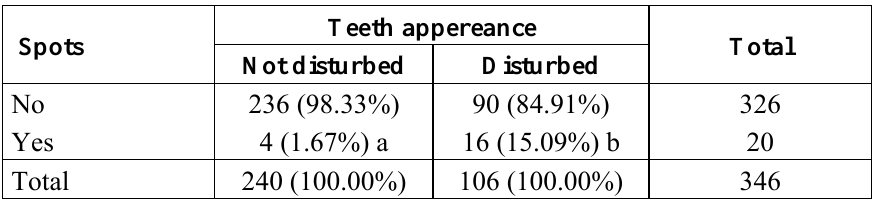
Table 7. Numbers of subjects and perceptions of teeth appearance (with and without spots), Caapiranga, AM, Brazil,